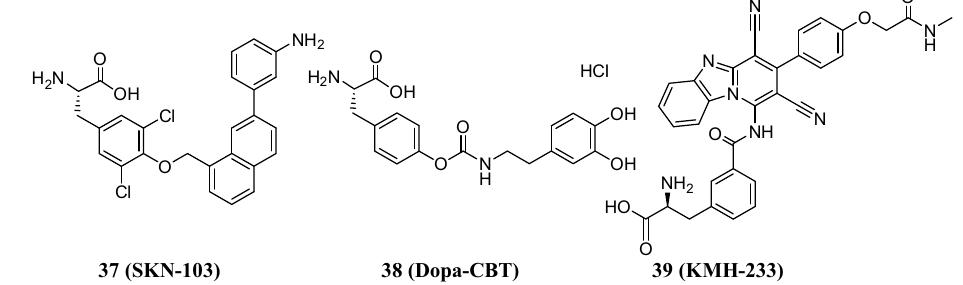
Figure 13: Chemical structures of compounds 37 –